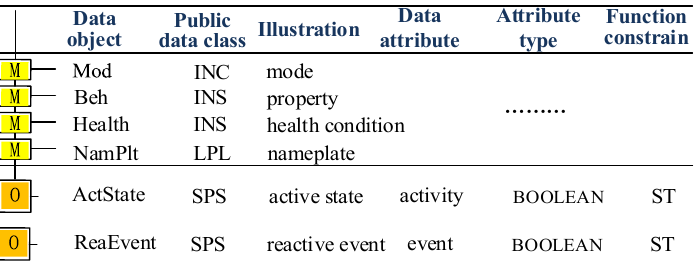
Figure 4. Data model of EXPD and EXPR.